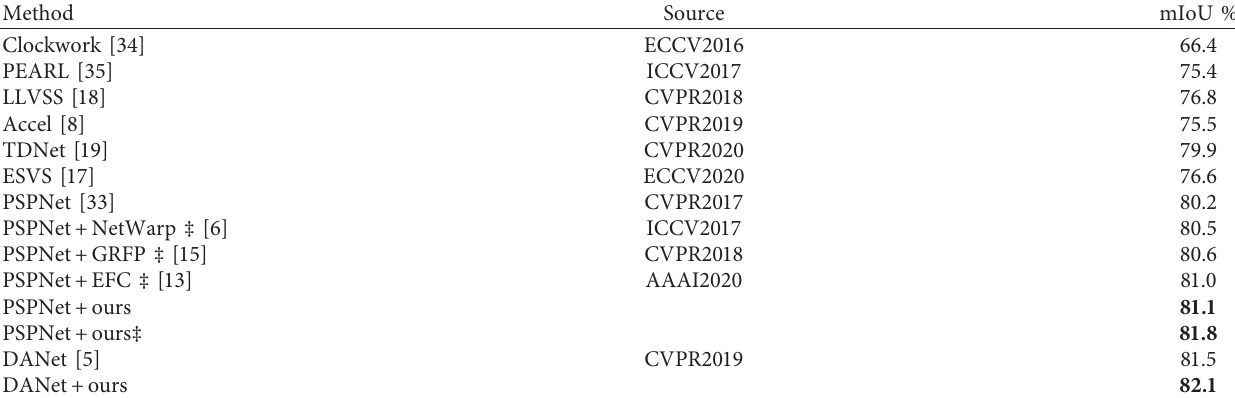
Table 6: Comparison of state-of-the-art semantic video segmentation models on the Cityscapes test set.